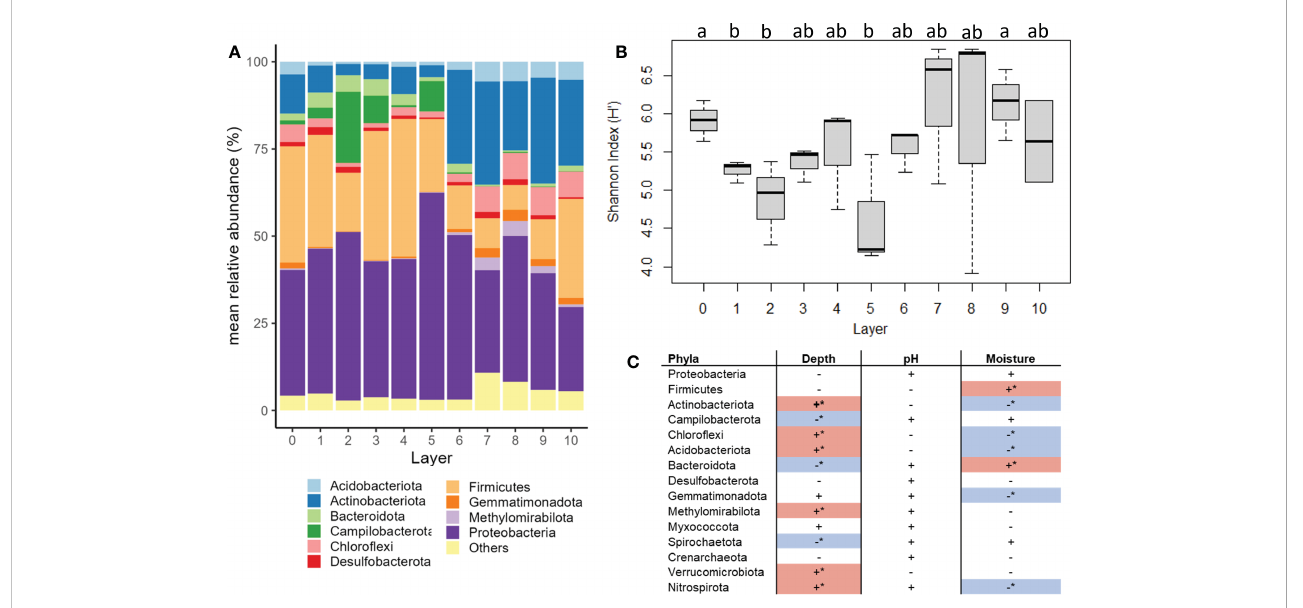
FIGURE 4 (A) Mean relative abundance of most abundant phyla across each of the site layers. (B) Changes in Shannon index with soil depth. Differences were compared using Wilcoxon test adjusted for false-discovery rate. A Pvalue of <0.05 was considered statistically signi fi cant. Different letters above bars indicate signi fi cant differences between soil depths. Lines in boxes represent medians. The top and bottom of each box represent the fi rst and the third quartiles, respectively. Whiskers indicate data ranges. (C) Spearman Correlation analysis showing correlation of relative abundance of most abundant phyla with depth, pH and moisture. Signi fi cant correlations are shown with an * and highlighted in red for positive correlation and blue for negative